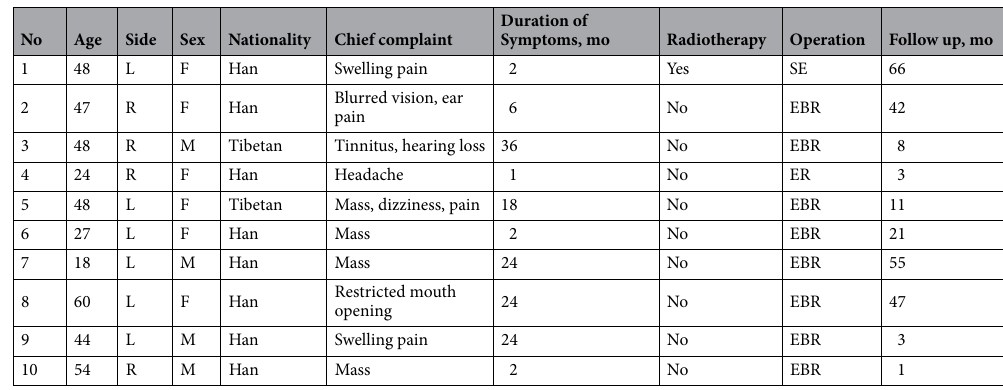
Table 1. Baseline characters 10 Patients of PVNS in the TMJ stretching of the skull base. L Left, R Right, F Female, M Man, EBR en bloc resection, ER Extensive resection, SE Subtotal excision, mo =